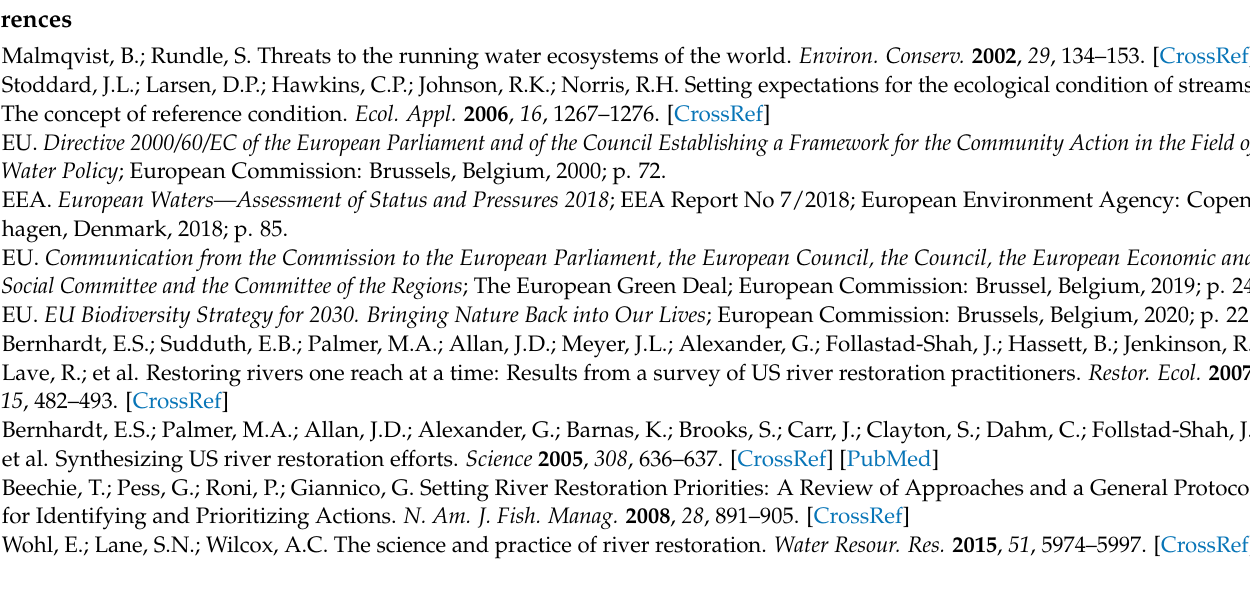
Tabanus sp. Tipula